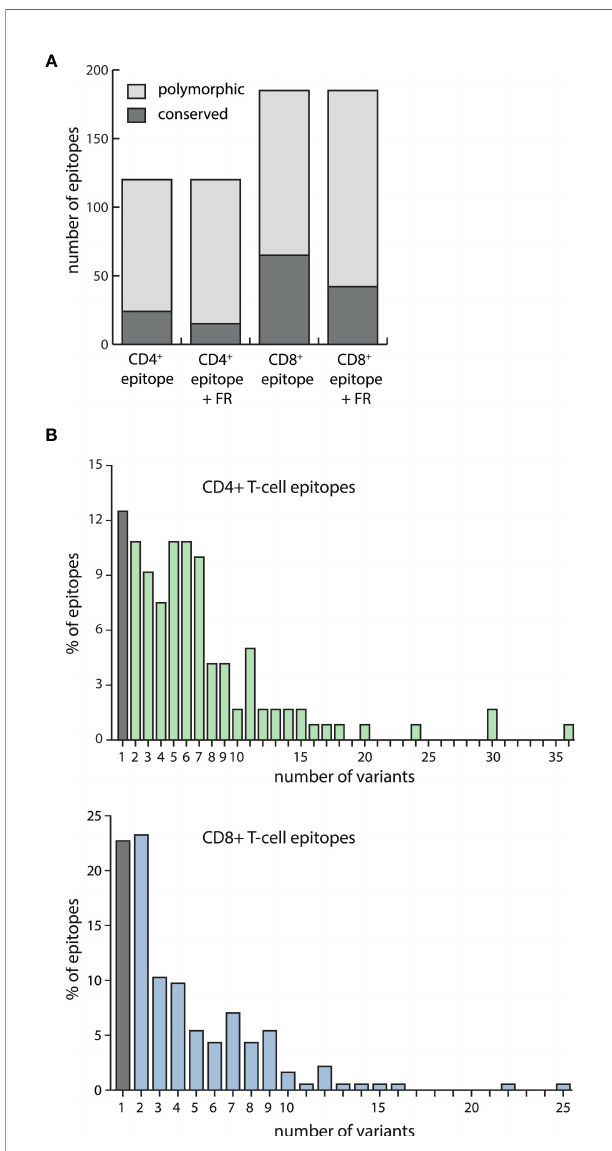
FIGURE 1 | EBV-speci fi c CD4+ and CD8+ T-cell epitope variability among strain variants. (A) Amino acid sequences of 120 EBV-speci fi c CD4+ T-cell epitopes and 185 CD8+ T-cell epitopes, either alone or including their fl anking regions (FR), were assessed for polymorphisms in 168 EBV strains. Exchanges, insertions, and deletions of single or several amino acids were regarded as polymorphisms. Depicted is the number of epitopes +/- their fl anking regions that were found to be conserved or polymorphic among the analyzed viral strains. (B) For each of the 120 CD4+ (upper graph) and 185 CD8+ (lower graph) T-cell epitopes including their fl anking regions, the number of sequence variants among 168 EBV strains was